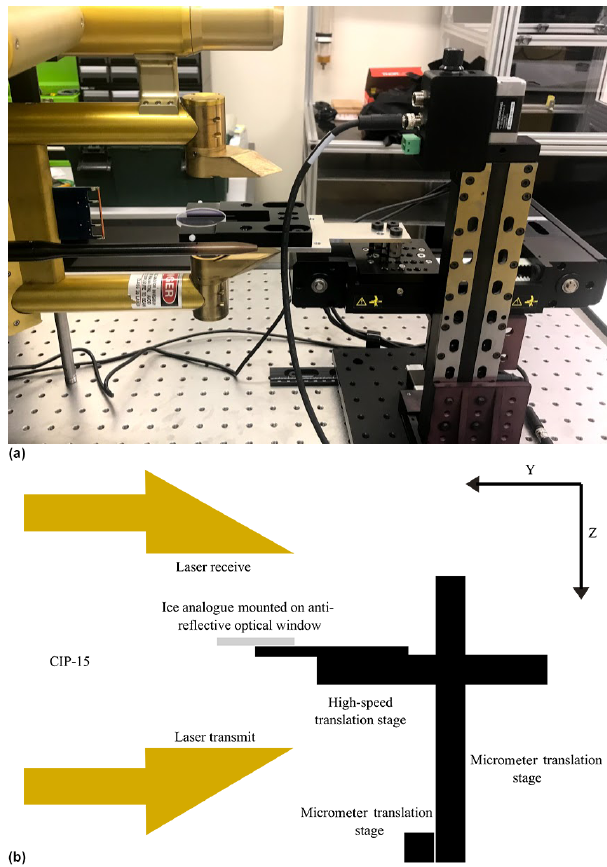
Figure 2. (a) Image of the experimental set-up for the ice crystal analogue tests of the CIP-15. Panel (b) shows a schematic of the experimental set-up. The CIP-15 is horizontally mounted on the left of the image. The translation stages used to move ice crystal ana- logues through the CIP-15 sample volume are shown on the right of the image. The x axis is perpendicular to the plane of